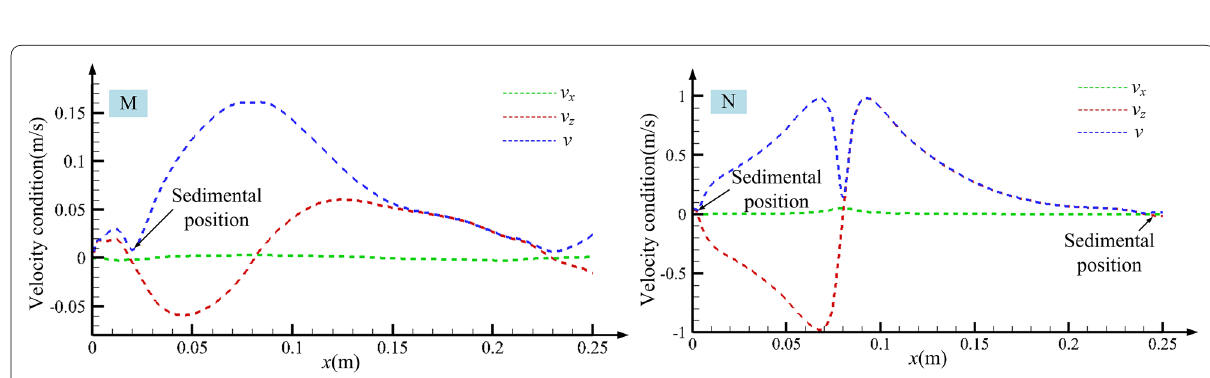
Figure 10 Velocity condition for Line M and